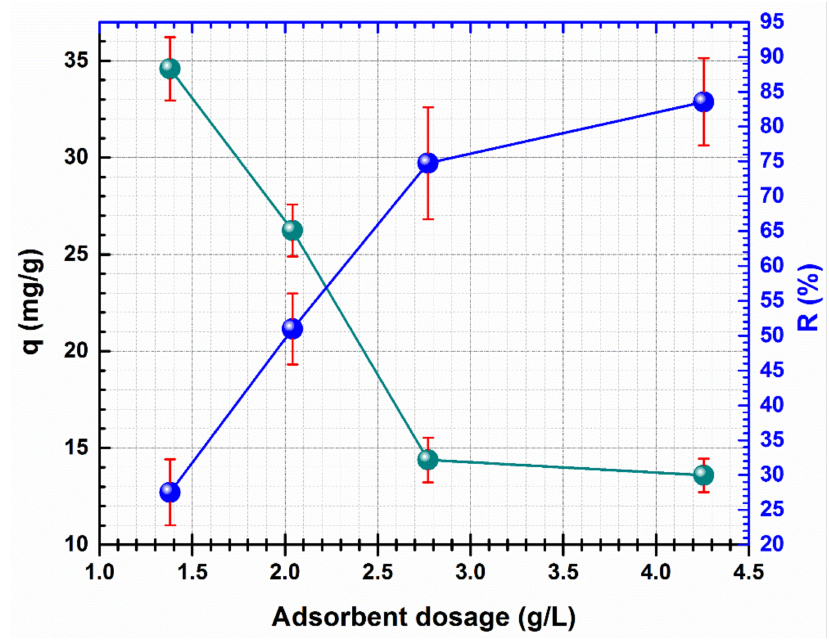
Figure 5. Effect of the adsorbent dosage on the adsorption of Cd (II) by CF@CMC. The data show that varying the adsorbent dose from 1.4 g/L to 4.26 g/L and keep- ing constant the other parameters (pH 5, initial concentration of 100 mg/L,